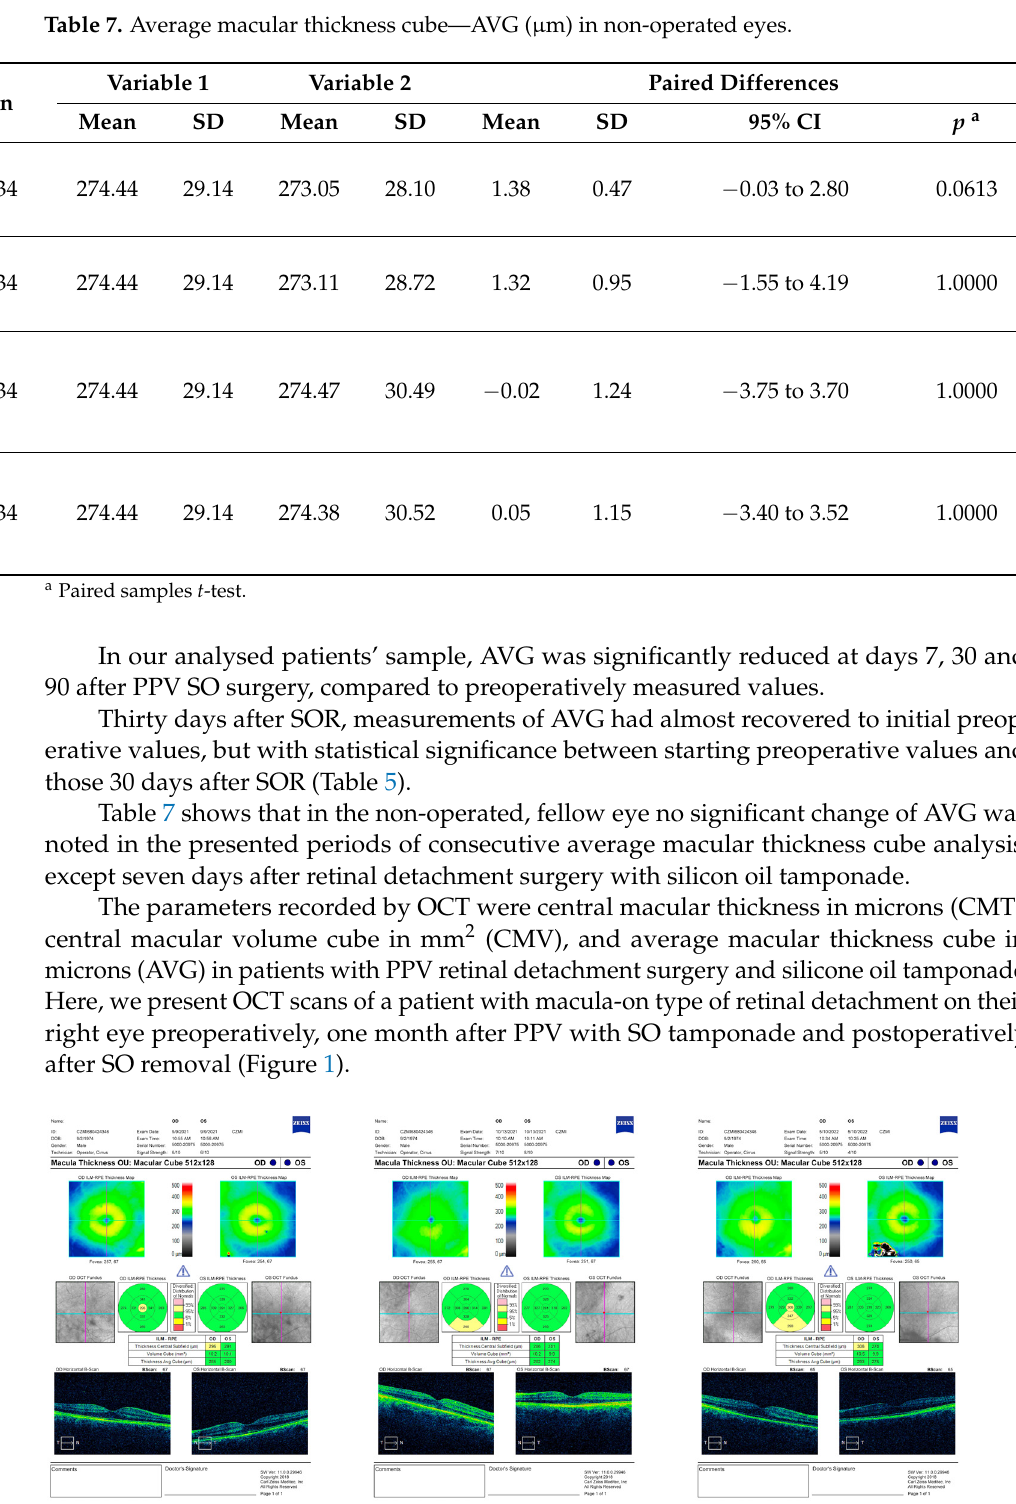
Figure 1. OCT scan printouts of a patient with macula-on type of RD on right eye preoperatively, one month postoperatively and six months after SO removal (from left to right).